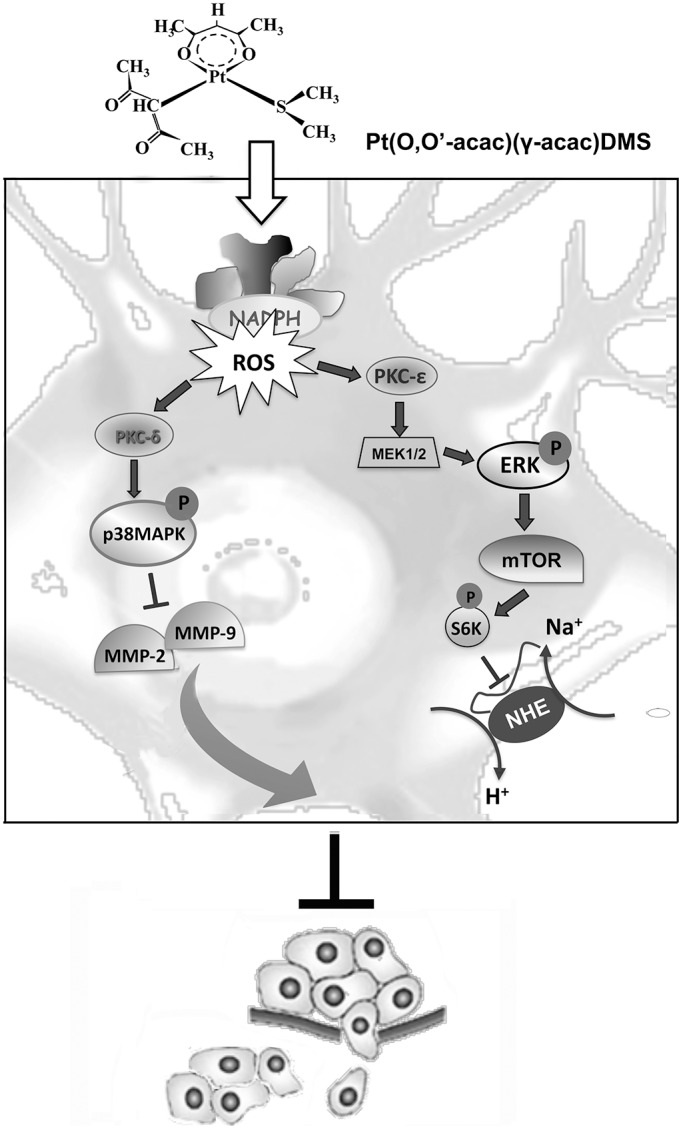
Mechanisms of [Pt(acac)2(DMS)]-mediated inhibition of human neuroblastoma SH-SY5Y cell migration and invasion.[Pt(acac)2(DMS)] inhibites NHE1 activity through PKC-ε and downregulates MMP-2/9 production and secretion through PKC-δ starting from NADPH ROS generation.